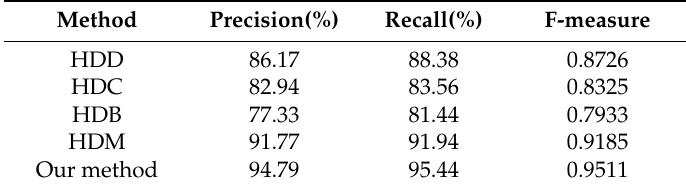
Table 3. Precision, Recall and F-measure of our method and four competing